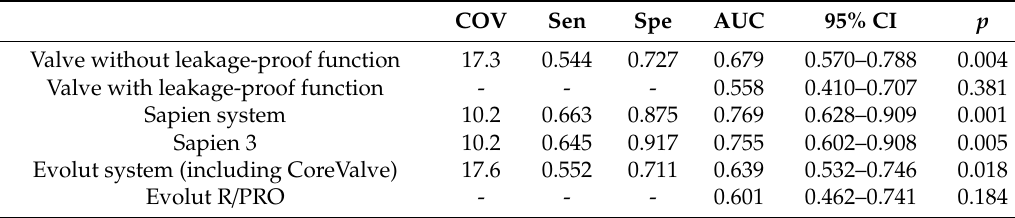
Figure 3. Receiver operating characteristic curves of optimal oversizing index for prediction absence of paravalvular leakage in each type of TAVI valve. AUC, area under the curve; CI, confidence interval; COV, cut-o ff value; TAVI, transcatheter aortic valve implantation. Table 4. The cut-o ff value of oversizing index of predicting absence of paravalvular